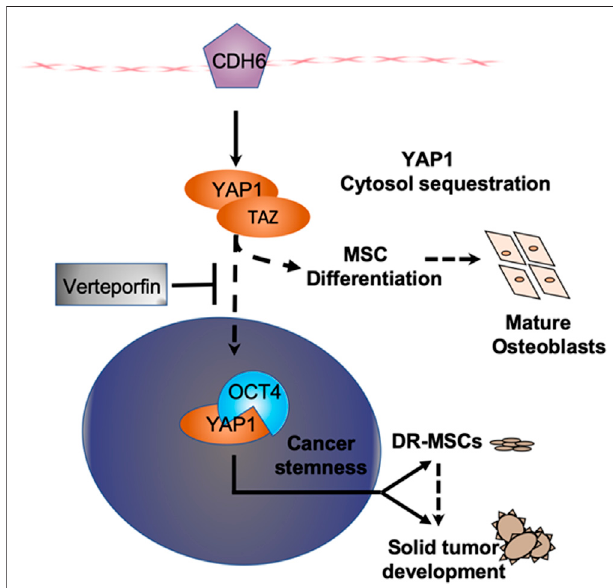
FIGURE 5 | YAP1-related signaling and associated proteins CDH6 and OCT4.YAP1-relatedsignalingandassociatedproteinsCDH6andOCT4were signi fi cantly up-regulated ( p = 4.25E-8). Upon mechanical strain or cellular contact, cadherin can induce YAP1/TAZ nuclear localization, upregulate transcription of OCT4, and promote MSC stemness. Vertepor fi n reduces levels of YAP1, CDH6, and OCT4, inhibits YAP1 nuclear localization, induces YAP1 cytosolic sequestration, and promotes MSC